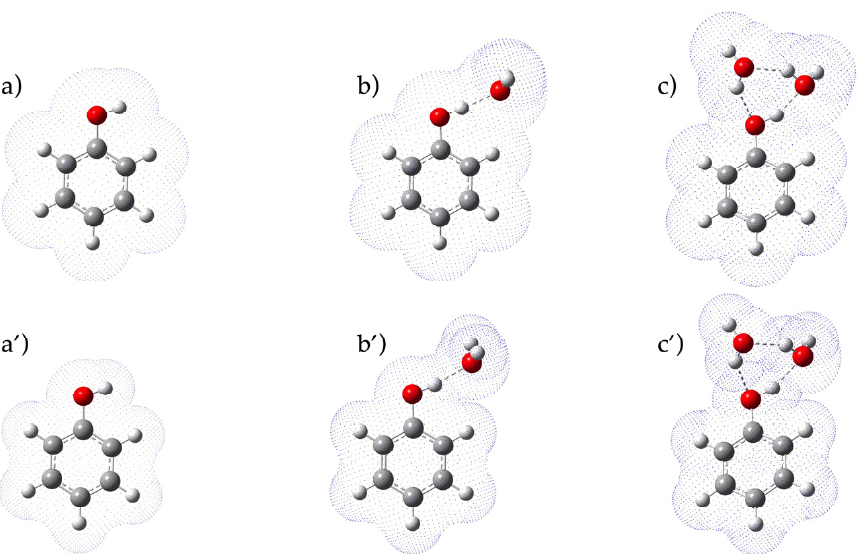
Figure 2. Solvation cavity of phenol with different models: IEFPCM in the presence of 0 ( a ), 1 ( b ) and 2 ( c ) explicit water molecules; SMD in the presence of 0 ( a’ ), 1 ( b’ ) and 2 ( c’ ) explicit water molecules. Geometry optimization performed with CAM-B3LYP 6-311G+dp (C: grey; H: white; O: red).